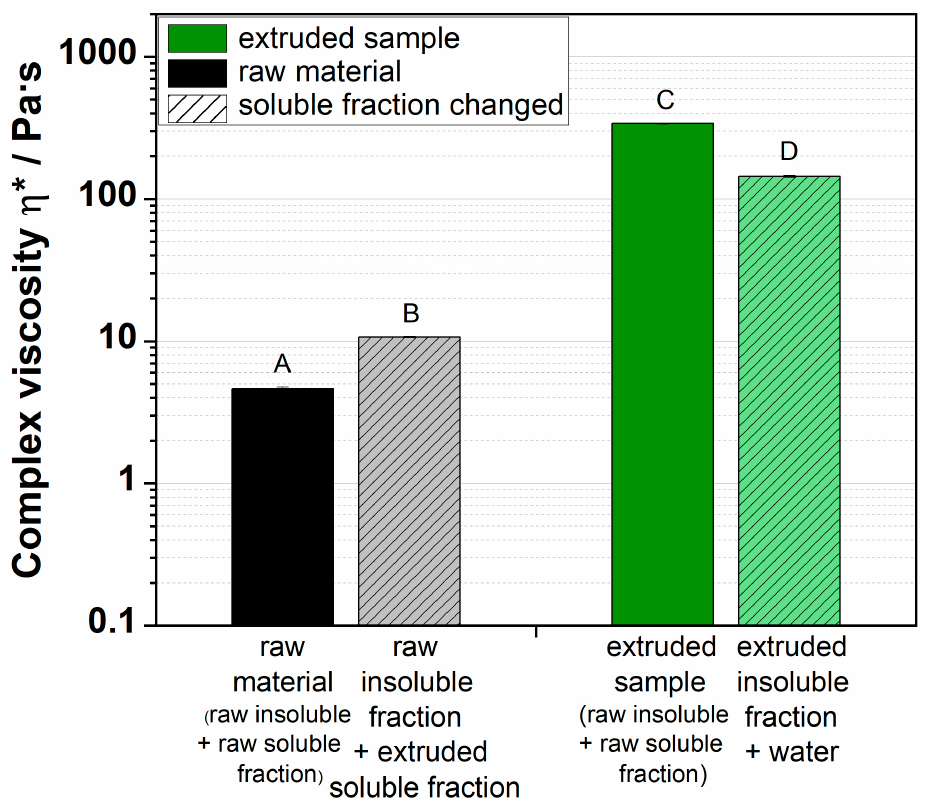
Figure 8. Change in complex viscosity of dispersions of raw material, extruded sample (W H2O = 17%, n = 700 min − 1 ) (full), and samples with a replaced soluble fraction (soluble fraction of treated sample / new water) (dashed). A–D Mean values within a row that are marked with di ff erent letters di ff er significantly ( p <